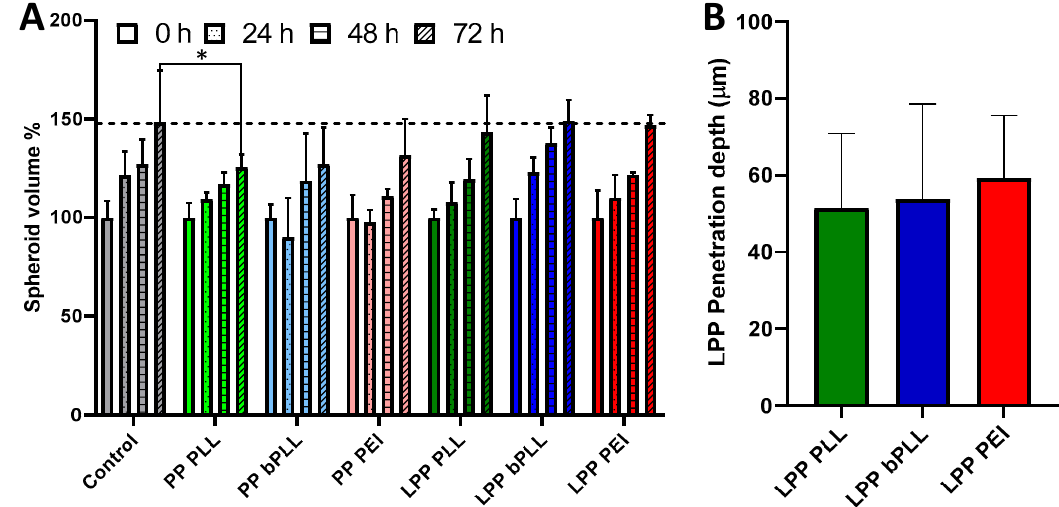
Figure 4. Growth of A549 multicellular spheroids treated with PPs and LPPs for 3 d ( A ); Penetration depth of LPPs (with Texas Red-labeled lipid) in 3D spheroids evaluated by confocal microscopy ( B ). Data are Means ± SD, n = 3. * p < 0.05 (Student’s t-test). The average initial spheroid size was 507.2 ± 19.5 µm.